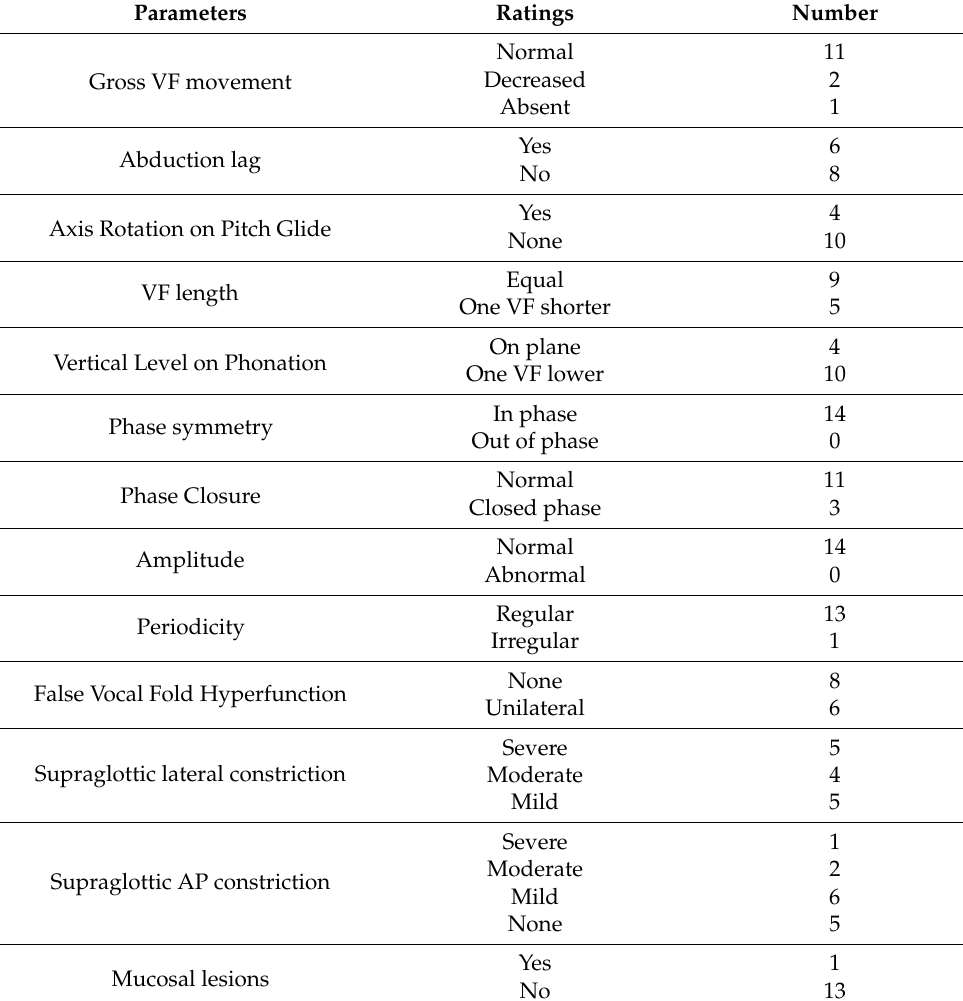
Table 7. Stroboscopy findings in